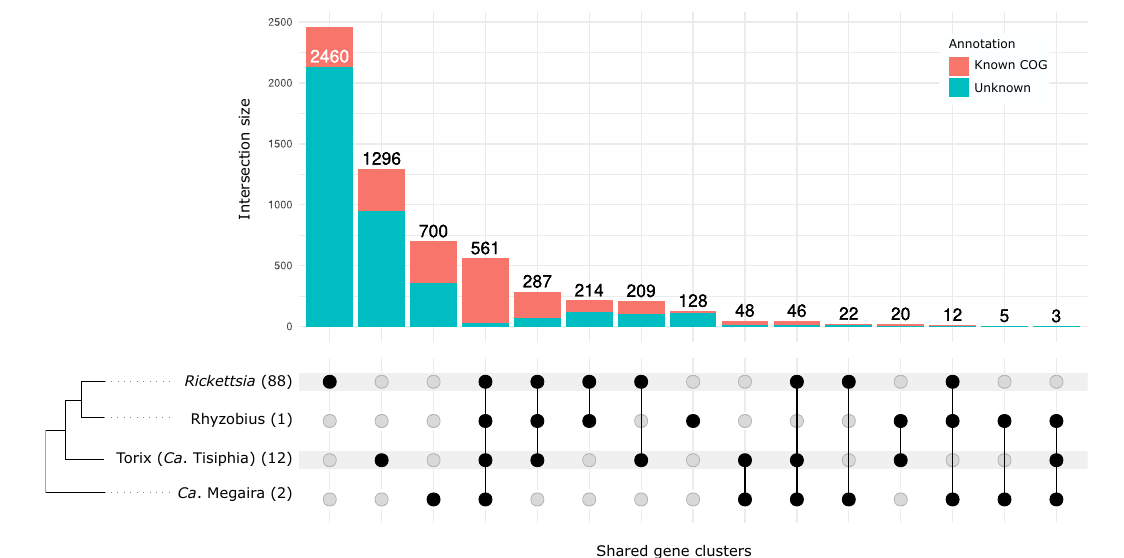
Fig. 3 Gene content comparison. Shared and unique gene clusters across genus putative genus clusters Rickettsia , Rhyzobius, Torix and ‘ Ca . Megaira ’ as suggested by GTDB-tk. Vertical coloured bars represent the size of intersections (the number of shared gene clusters) between genomes in descending order with known COG functions displayed in coral and unknown in blue. Black dots mean the cluster is present and connected dots represent gene clusters that are present across groups. Numbers in parenthesis represent the number of genomes used in the analysis. Source data are provided in Source Data.